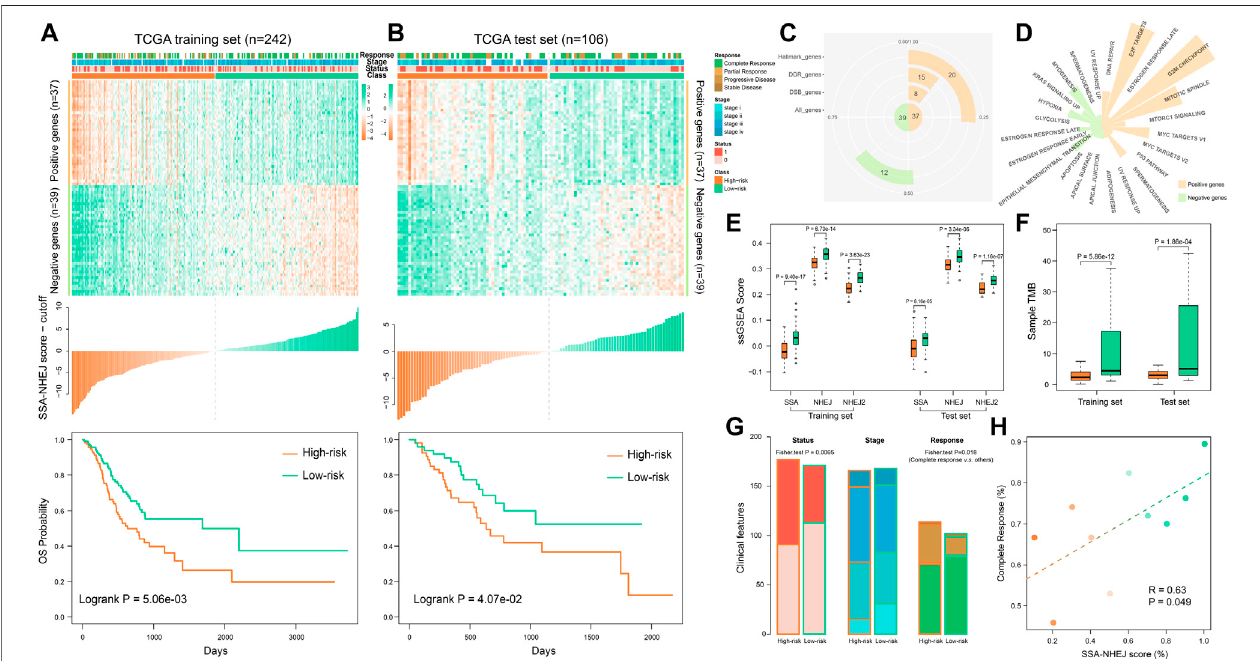
FIGURE 2 | Using HR-LR model to predict survival risk of samples. (A) Top panel shows the expression pro fi le of the SSA and NHEJ-related marker genes in the TCGA training set. The middle panel shows the score ofeach training sample by the HR-LR model. The bottom panel represents the Kaplan – Meier survival plot ofhigh- risk and low-risk samples in the training set. (B) Expression pro fi le, sample score, and Kaplan – Meier survival plot for TCGA test samples. (C) The statistic of 76 marker genes. (D) Marker genesrelated tocancerhallmarks. (E) Low-risk samplesare withsigni fi cantlyhigher SSAand NHEJ ssGSEA scoresintrainingand test sets. (F) Low-risk samples have signi fi cantly more somatic mutations. (G) Low-risk samples are with more alive, low stage, and complete response samples. (H) Correlation of SSA-NHEJ score with complete response. Samples were divided into ten groups according to their scores. Samples with higher scores are with a higher probability of complete